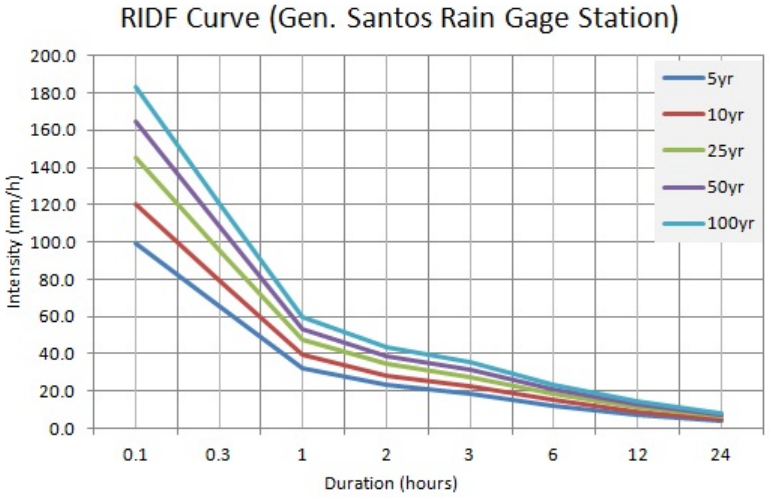
Fig. 2: Rainfall Intensity Duration Frequency curves of General Santos rain gage station